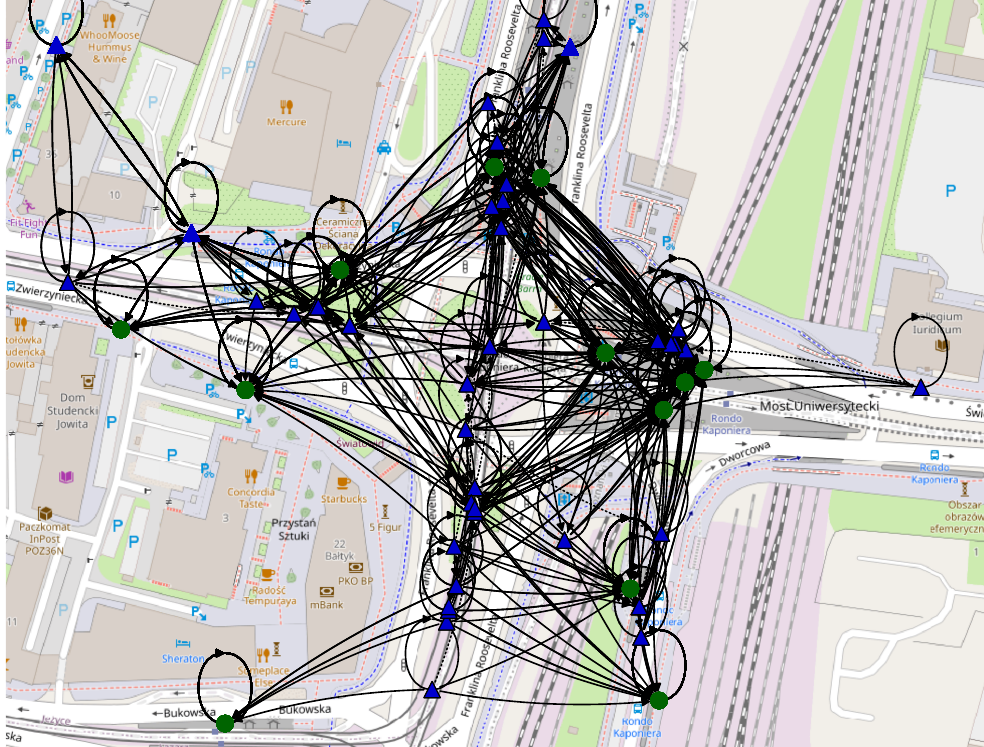
Figure 10. Space-time connectivity